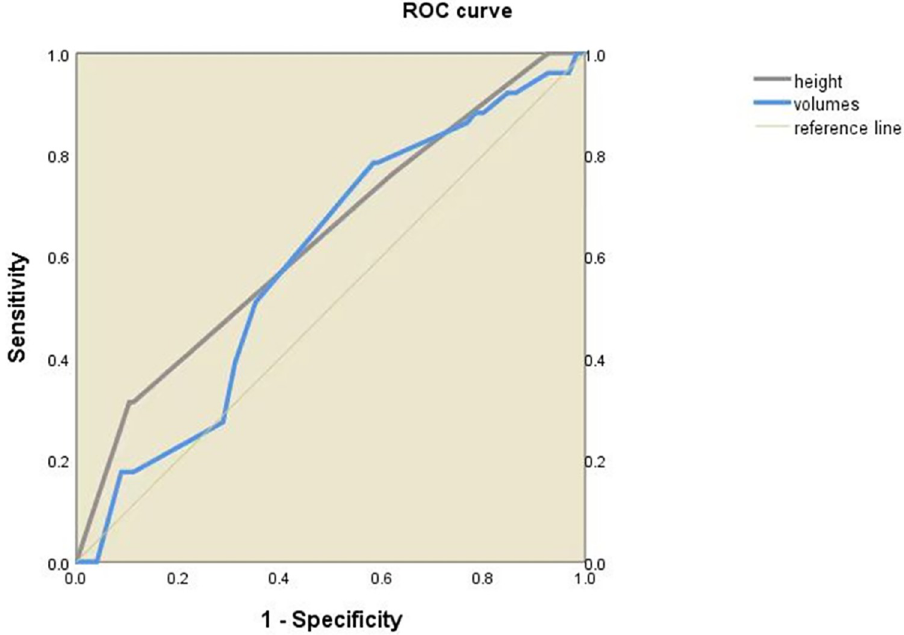
Fig 2. Premature rupture of membranes is predicted using the ROC curve with cone height and